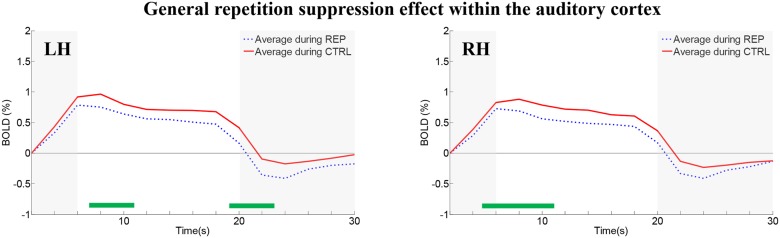
Mean of the group average time-courses of the REP and CTRL conditions within the auditory cortex on the STP (defined by main effect of environmental sound) in the left and right hemisphere (LH, RH).Significant differences between conditions are highlighted by the green bars in the bottom of the graphs (paired t-test, p<0.05, uncorrected). Gray shading denotes the rise and decay periods (for definition see Supporting Information).